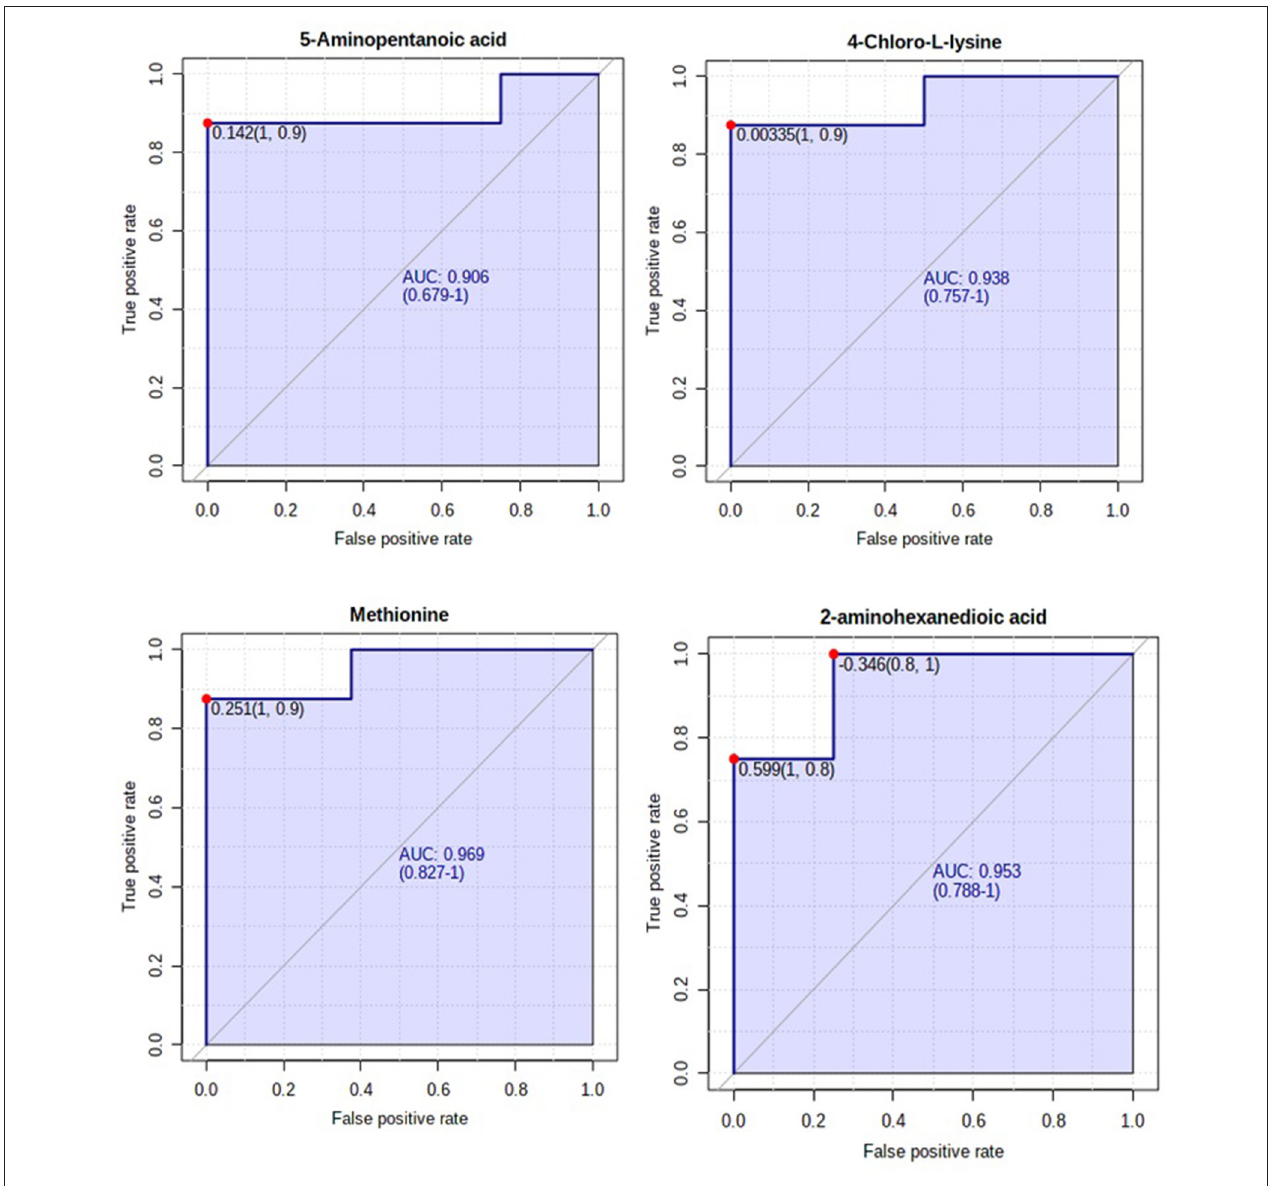
FIGURE 3 | Biomarker analysis of plasma amine/phenol metabolome. ROC curve analysis of candidate plasma amine/phenol biomarkers (methionine, 5-aminopentanoic acid, 2-aminohexanedioic acid, and 4-chlorolysine) of beef steer with divergent RFI values.